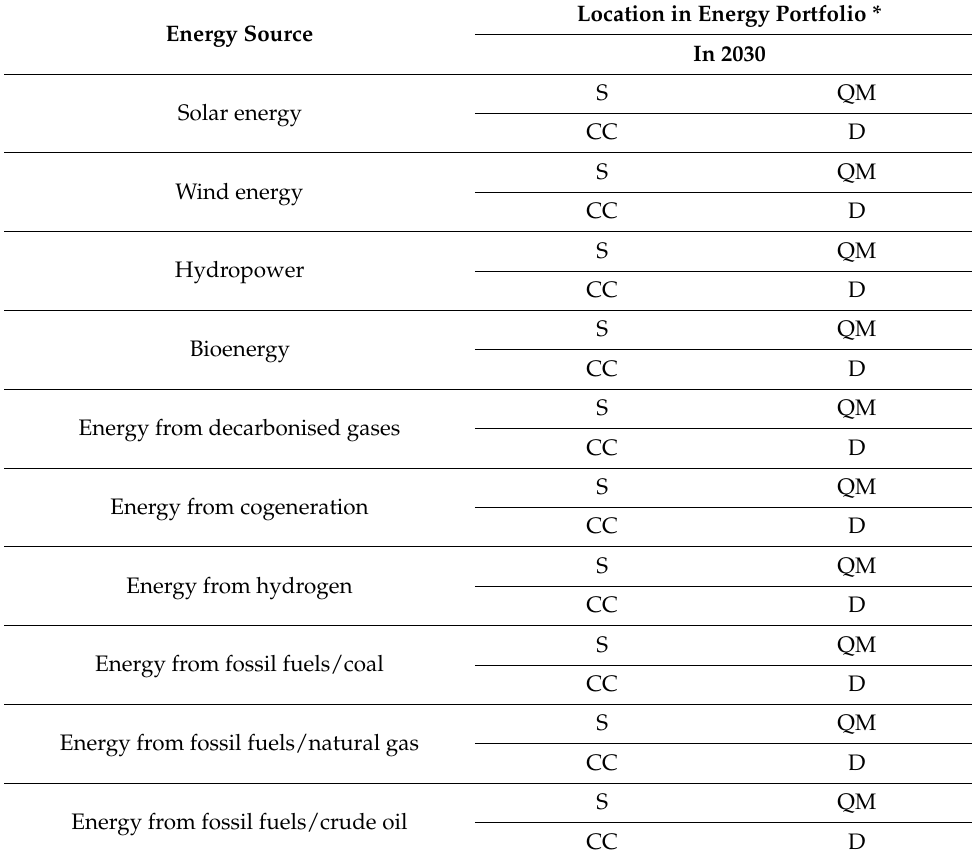
Table 1. Forecast energy sources portfolio for the provinces of Eastern Poland for the year 2030— results of legal and institutional